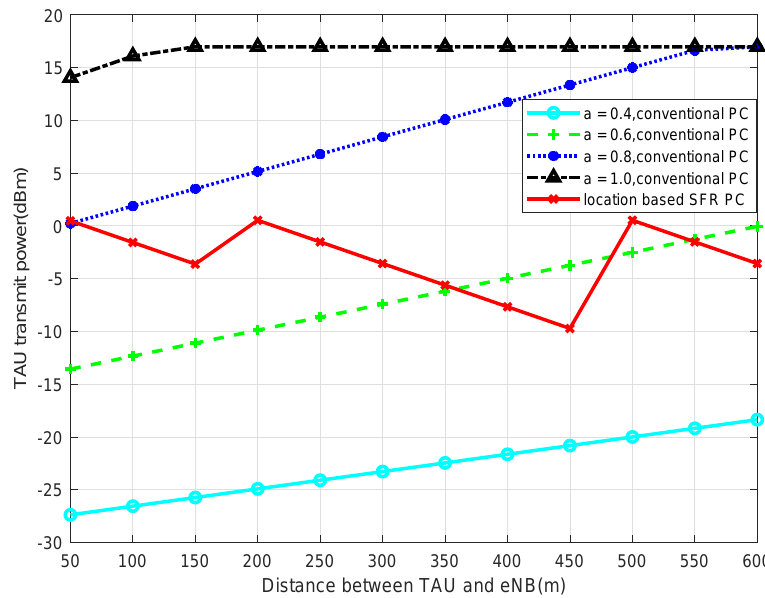
Figure 5. Transmit Power of TAU in